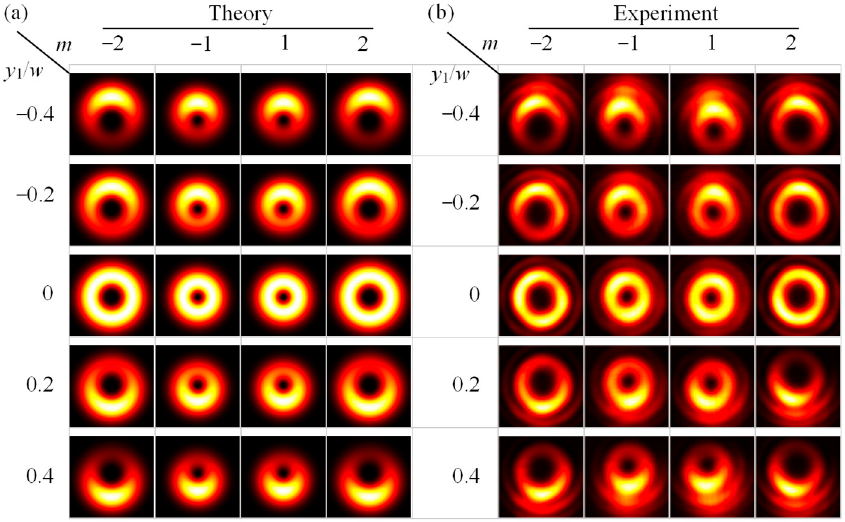
Figure 3. ( a ) Theoretically simulated and ( b ) experimentally measured intensity patterns of off-axis single vortex beams with different values of y 1 and m when w = 2.5 mm and x 1 = 0.